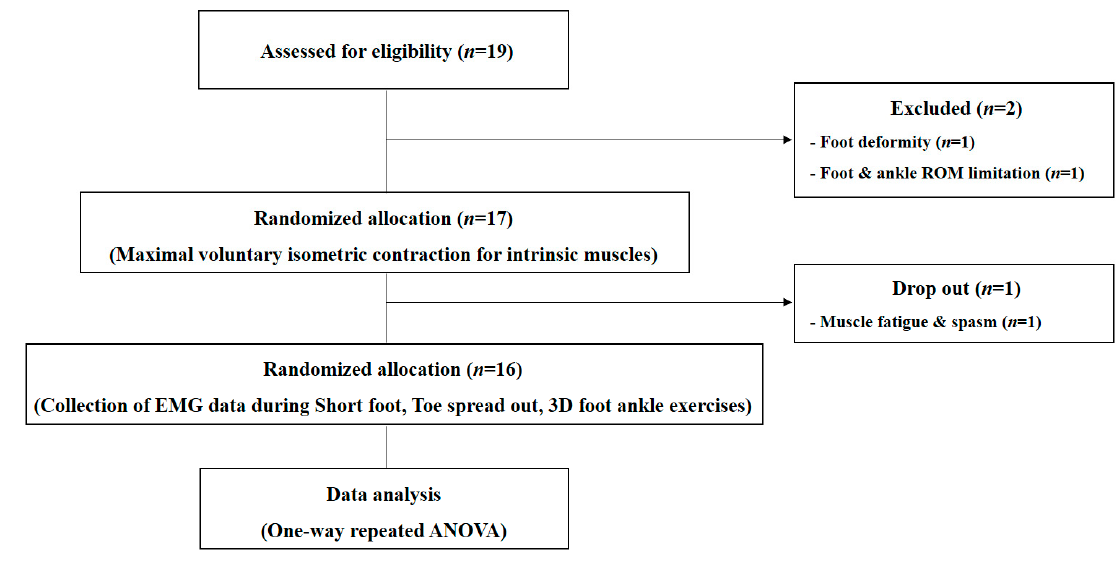
Figure 1. Diagram of the study design. ROM: range of motion; EMG: electromyogram; 3D: 3-dimensional; ANOVA: analysis of variance.